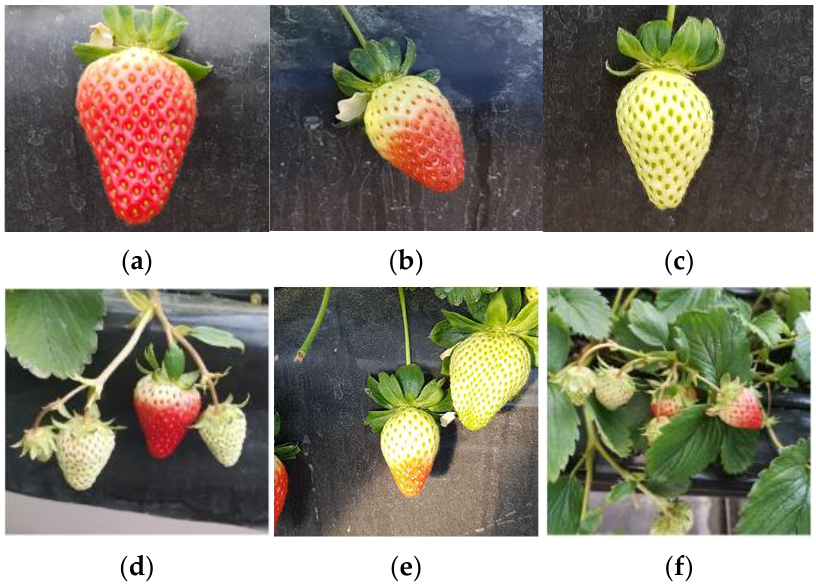
Figure 2. Images of strawberry samples collected under greenhouse environment. ( a ) Mature strawberry; ( b ) near-mature strawberry; ( c ) immature strawberry; ( d ) uncovered strawberry; ( e ) strawberry under strong light; ( f ) covered strawberry.